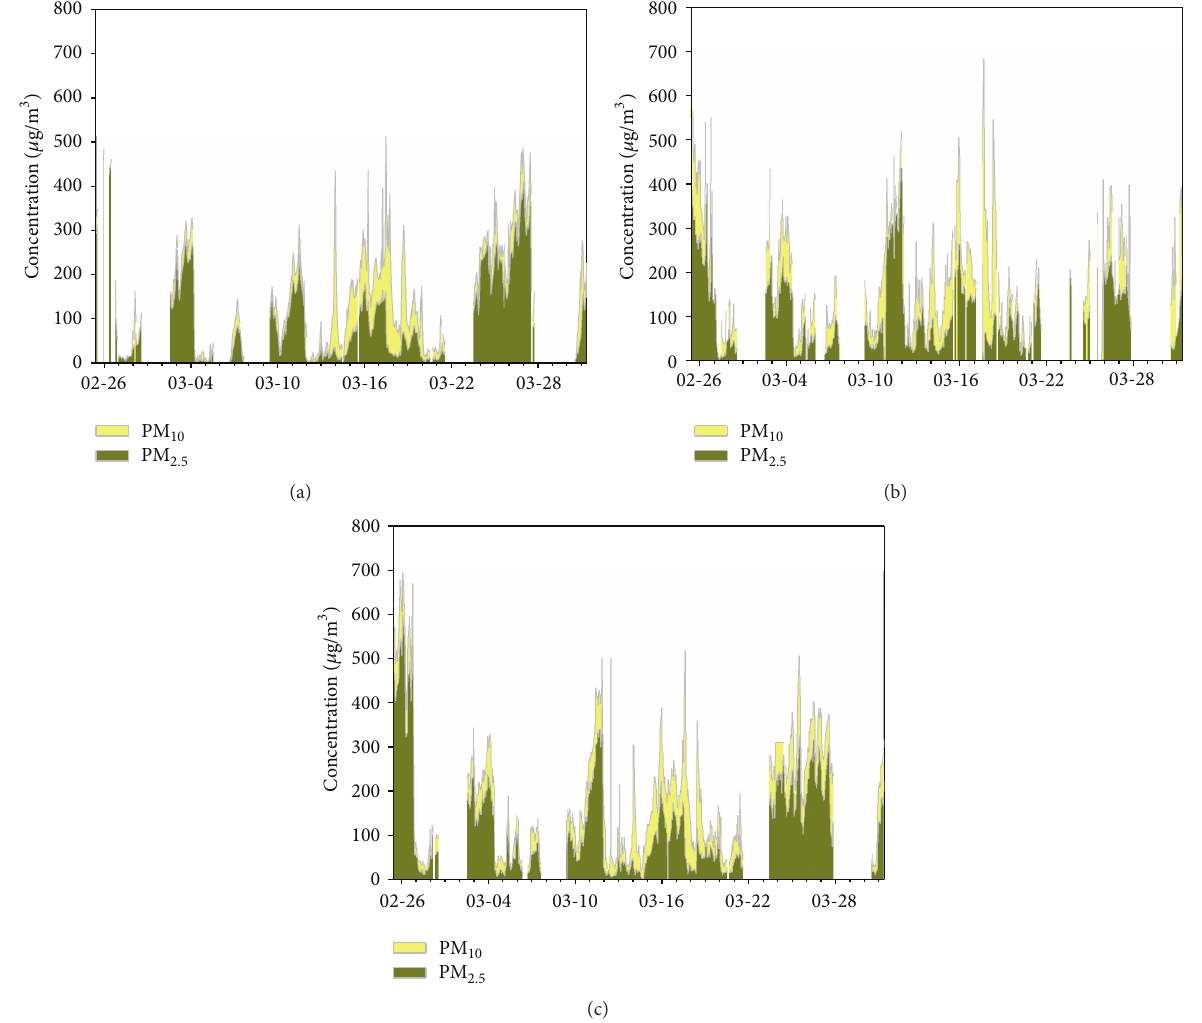
Figure 4: Mass concentration of major cities in China. (a) Beijing, (b) Tianjin, and (c) Hebei.